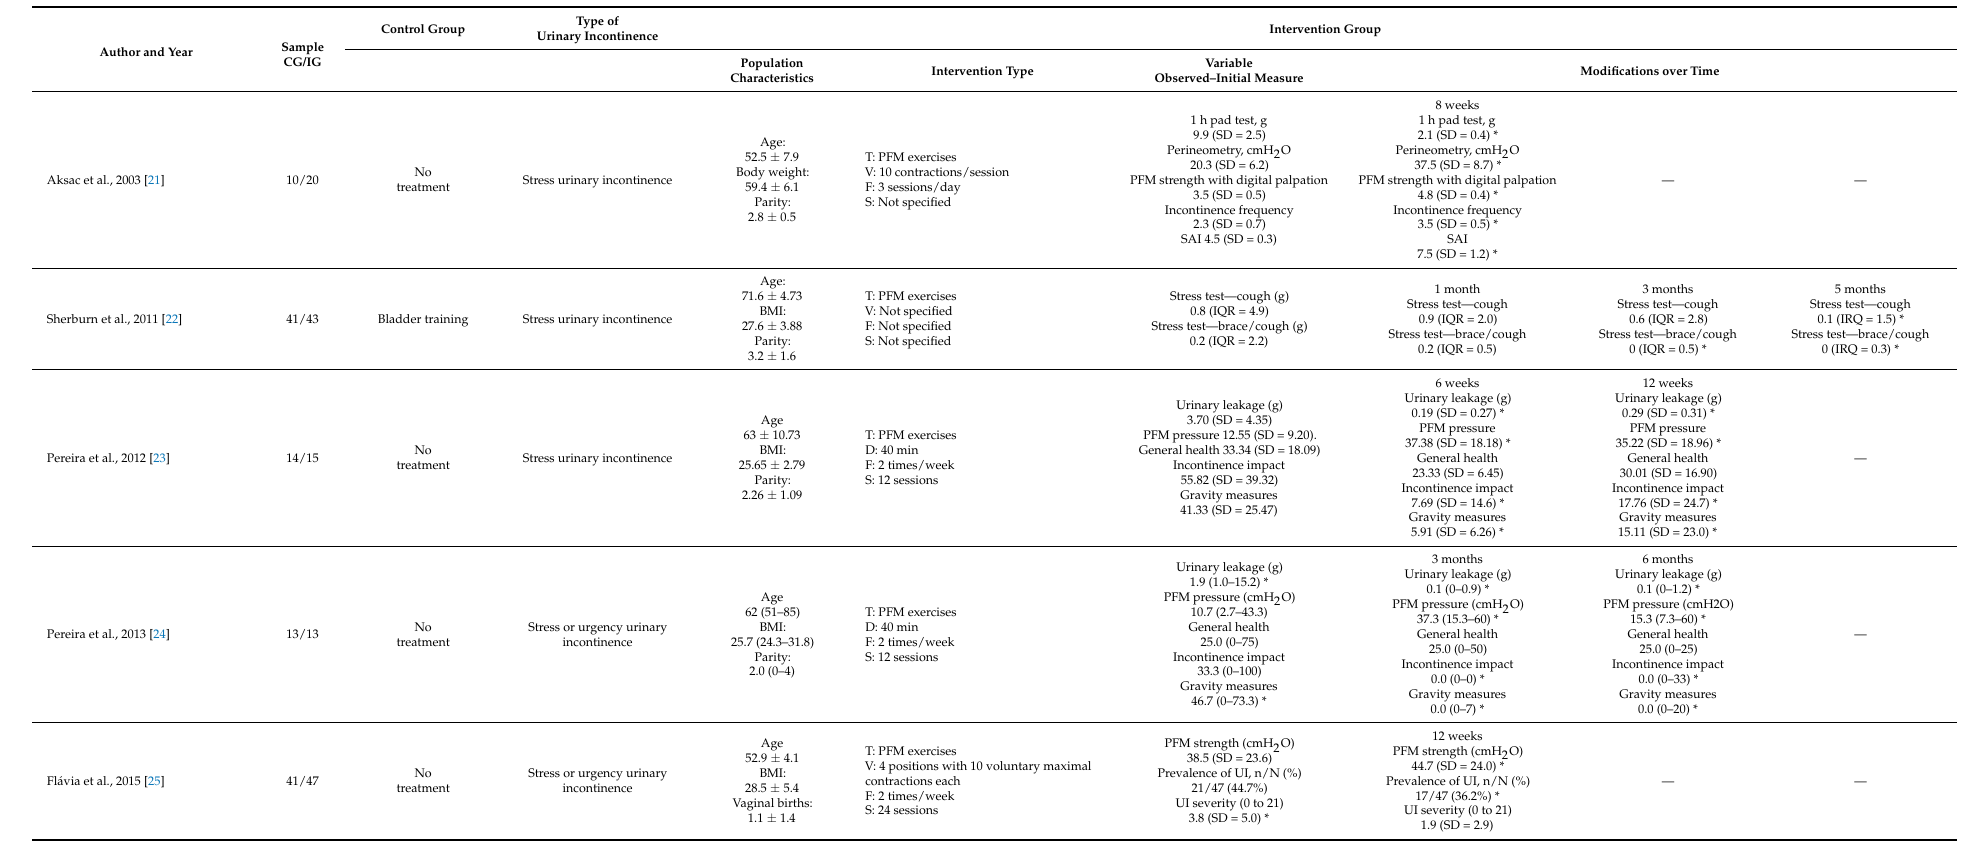
Table 2. Characteristics of the included